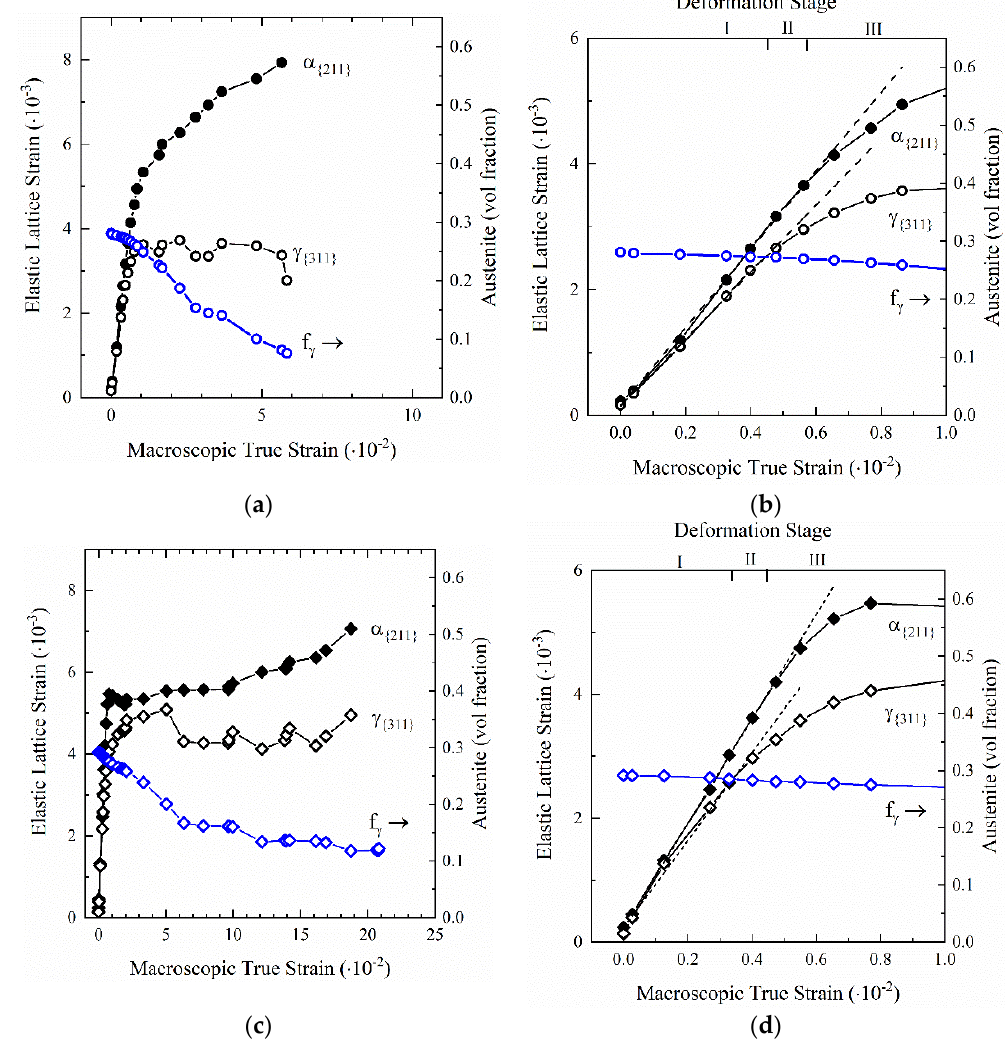
Figure 6. Elastic lattice strain as a function of macroscopic true strain for the {211} orientation of the BCC phases ( 𝛼/𝛼 ′ ) and {311} orientation of austenite for the ( a , b ) DS and ( c , d ) DS-T heat treatment conditions.